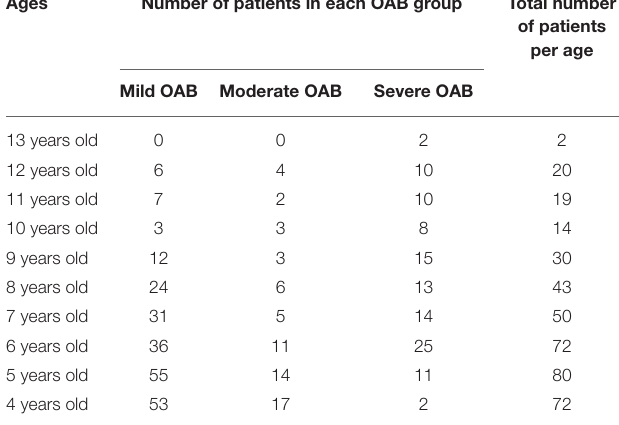
TABLE 1 | Age of children with